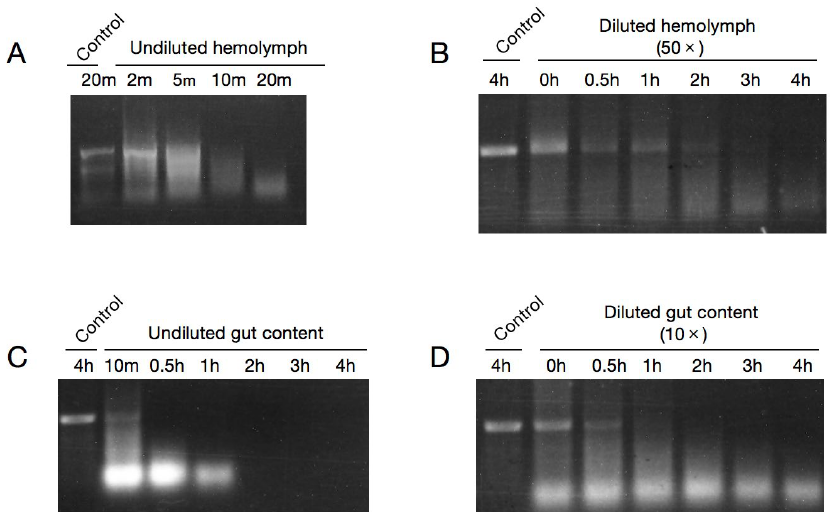
Figure 1. Representative gel images showing that dsRNA was rapidly degraded in either ( A , C ) undiluted or ( B , D ) diluted hemolymph and gut content collected from 2-day-old fifth-instar larvae. The relative stability of dsGFP was detected by 1% agarose gel electrophoresis after incubation for different time periods in 60 µ L tissue extracts (hemolymph or gut content) or nuclease-free water (control). m, minutes; h, hours.